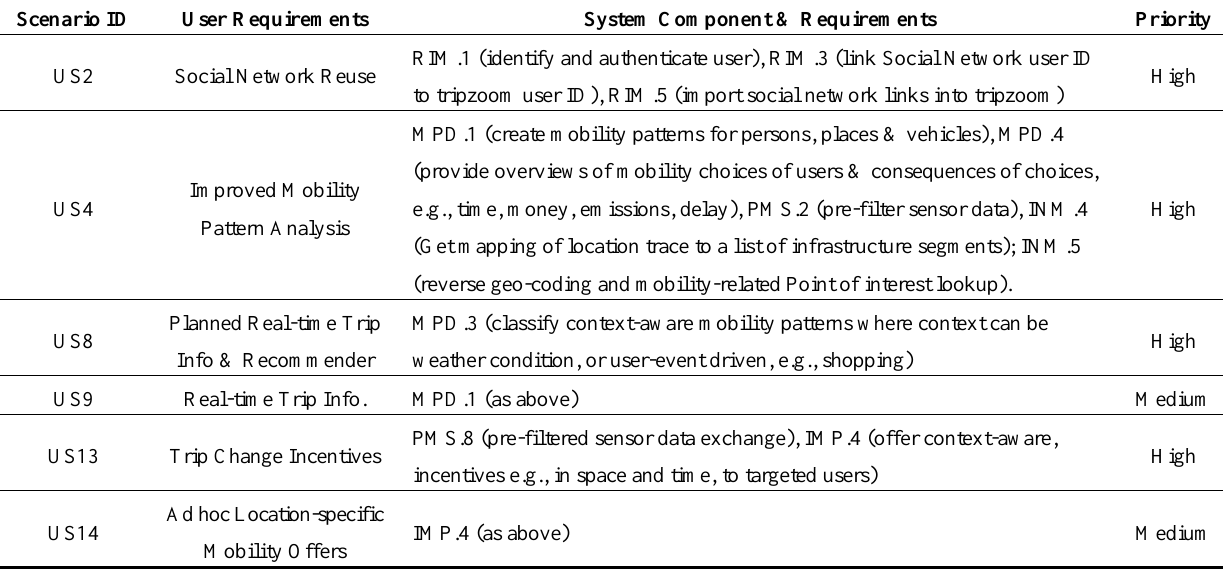
Table 1. Exemplar user requirements mapped to system requirements (RIM—Relation and Identity Manager; MPD—Mobility Pattern Detector; PMS—Personal Mobility Store; INM—Infrastructure Network Manager; MPD—Mobility Pattern Detector).